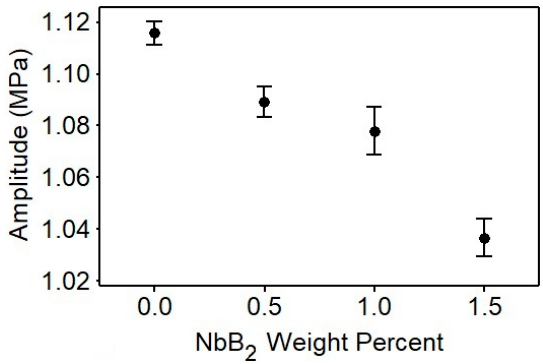
Figure 12. Histogram of the transformed amplitude of the peak.